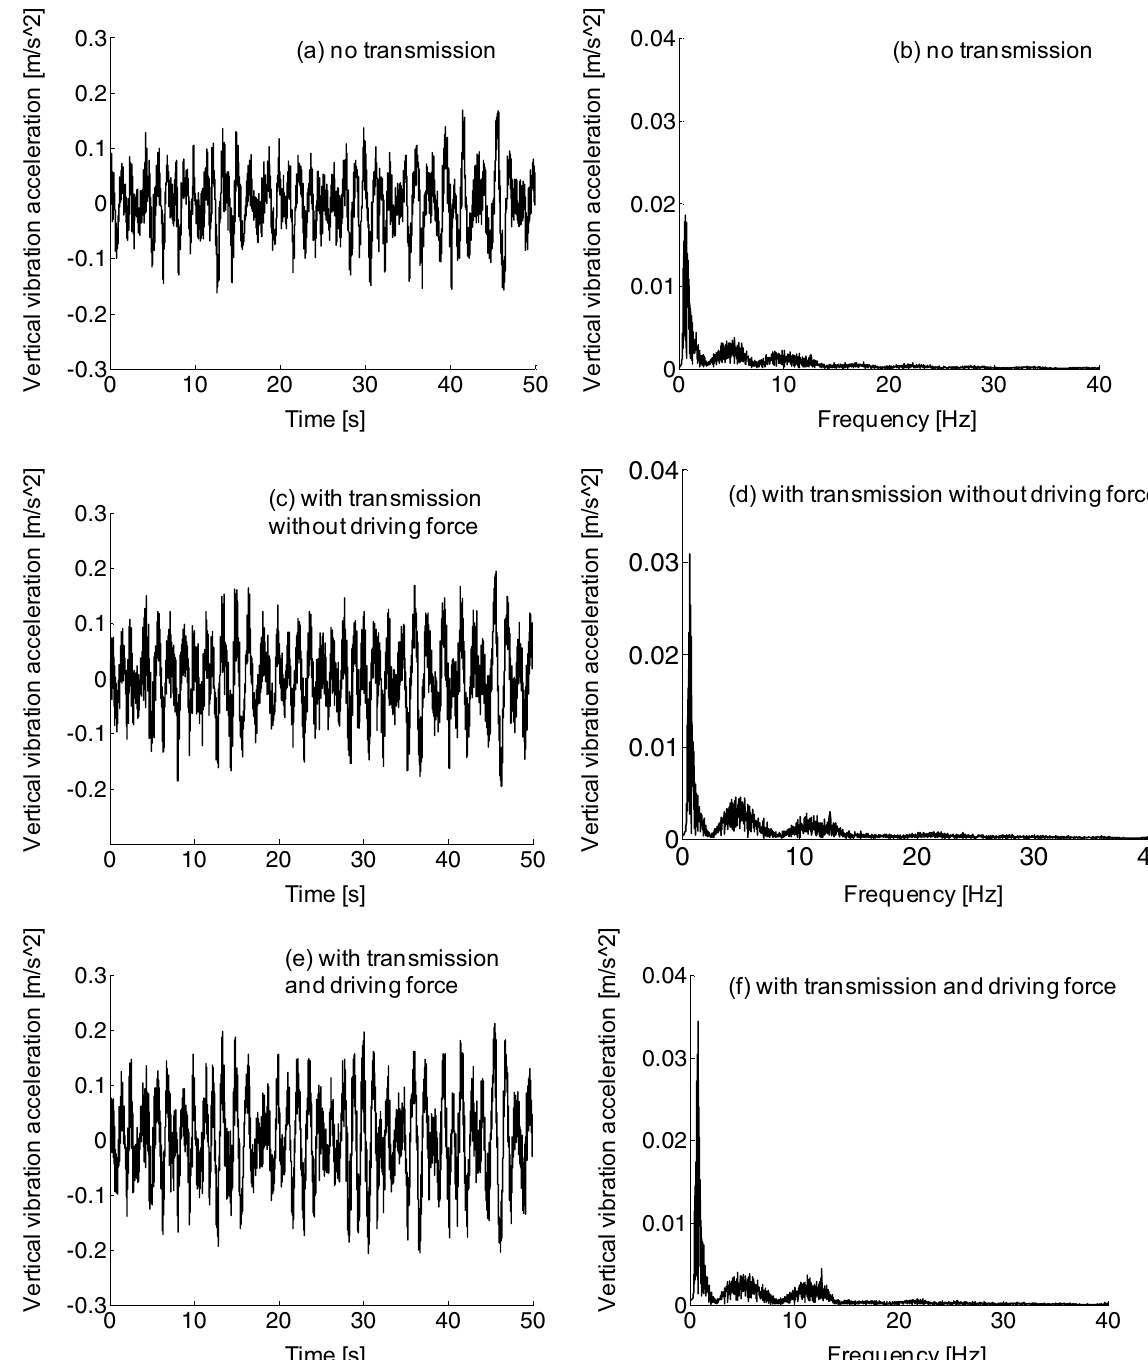
Figure 18. Car body vertical vibration acceleration, (a-b) no transmission, (c-d) with transmission without driving force, (e–f) with transmission and driving